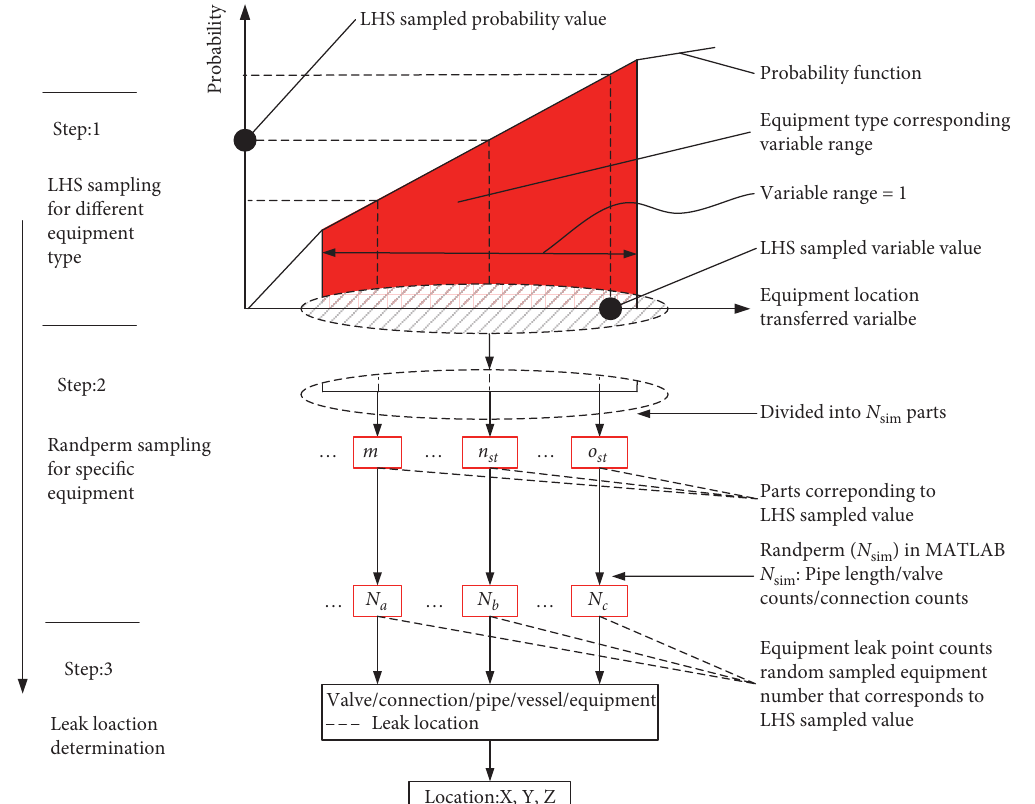
Figure 13: Procedure to get the specific coordinate of leak location.